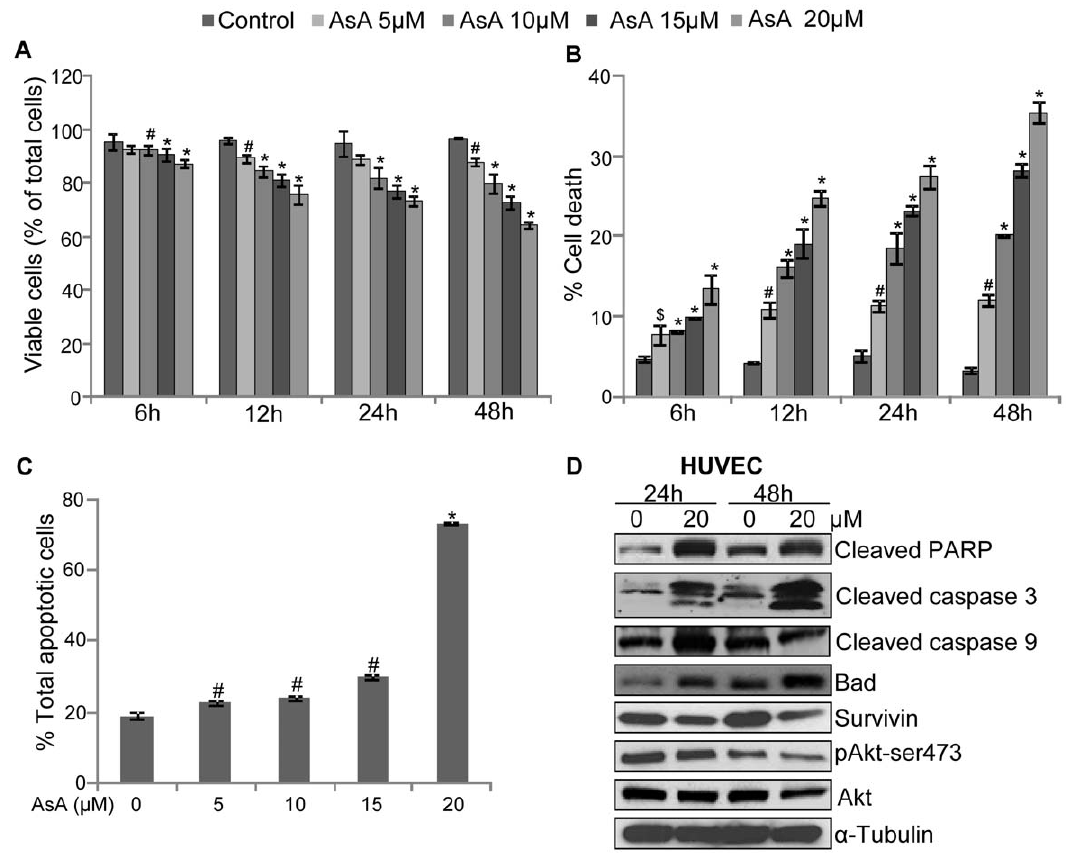
Figure 1. AsA inhibits growth and induces apoptosis in HUVEC. A & B. HUVEC (4 6 10 4 cells per well) were treated with DMSO or different doses of AsA (5–20 m M) in complete HUVEC media for 6, 12, 24 and 48 h. At each treatment time, both adherent and non-adherent cells were collected and processed for the determination of viable cell number and dead cells percentage as mentioned in ‘Materials and Methods’. C. HUVEC were treated with DMSO or AsA (5–20 m M) for 24 h and analyzed for apoptotic cell population using annexin V/PI staining as detailed in ‘Materials and Methods’. In panels A, B, & C, each bar represents the mean 6 standard deviation of three samples. These results were almost similar in two independent experiments. *, p # 0.001; # , p # 0.01; $ , p # 0.05. D. HUVEC were treated with DMSO or AsA (20 m M) for 24 and 48 h. After each treatment time, total cell lysates were prepared and analyzed for cleaved PARP, cleaved caspase 3, cleaved caspase 9, Bad, survivin, pAkt-ser473, and total Akt by Western blotting as detailed in ‘Materials and Methods’. In each case, membrane was also stripped and reprobed with anti- a -tubulin antibody to confirm equal protein loading.